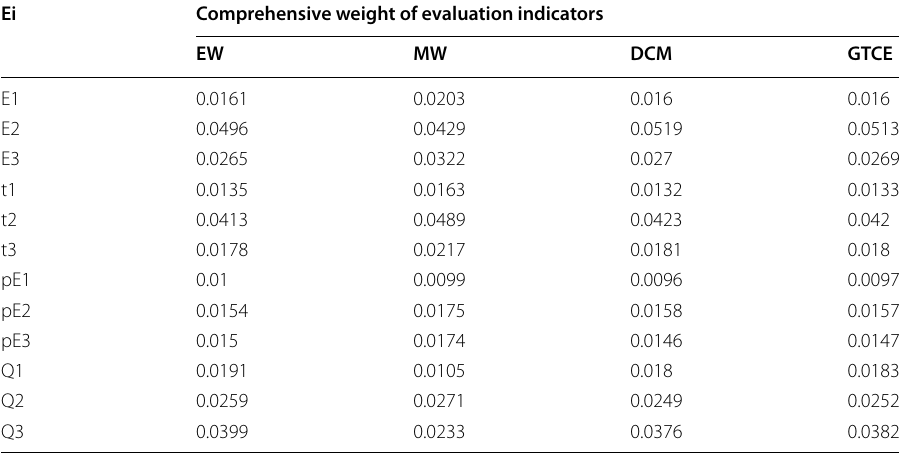
Table 1 Comprehensive weight of each evaluation index Ei Comprehensive weight of evaluation